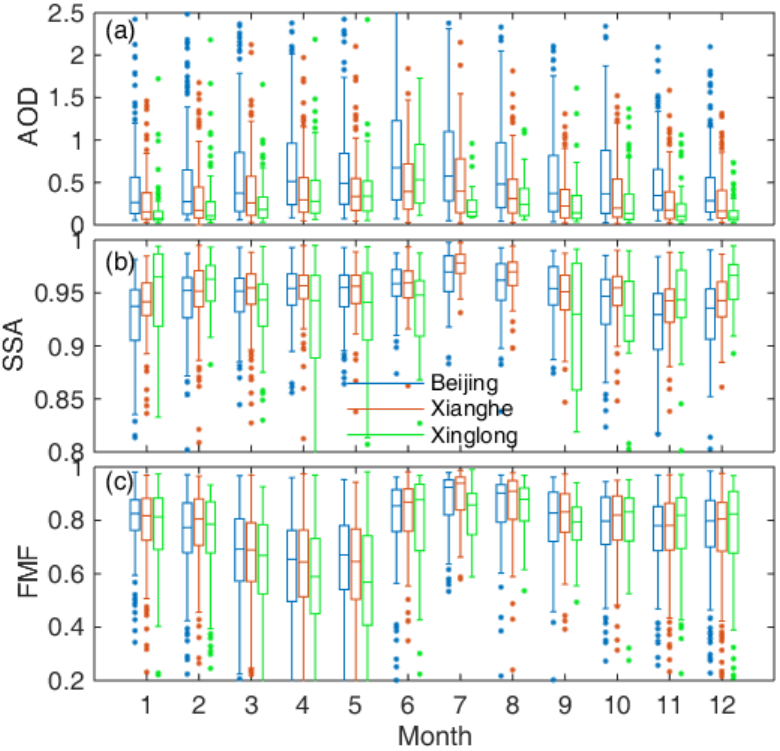
Figure 2. Statistical analysis showing monthly variation of AERONET AOD, Single Scattering Albedo (SSA), and fine mode fraction (FMF) values at Beijing (blue), Xianghe (firebrick), and Xinglong (lime) sites. The ends of each box denote the 25th and 75th percentiles of the distribution, the ends of the whiskers represent the 5th and 95th percentiles, and the line across the box is the median of the distribution.